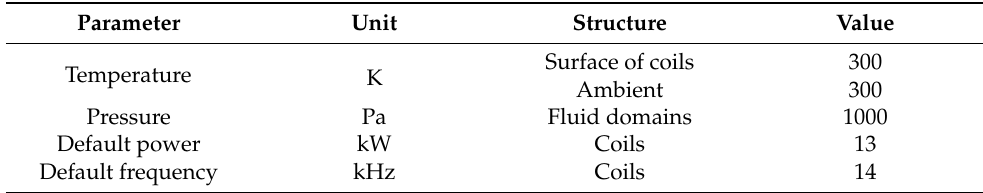
Table 4. Boundary